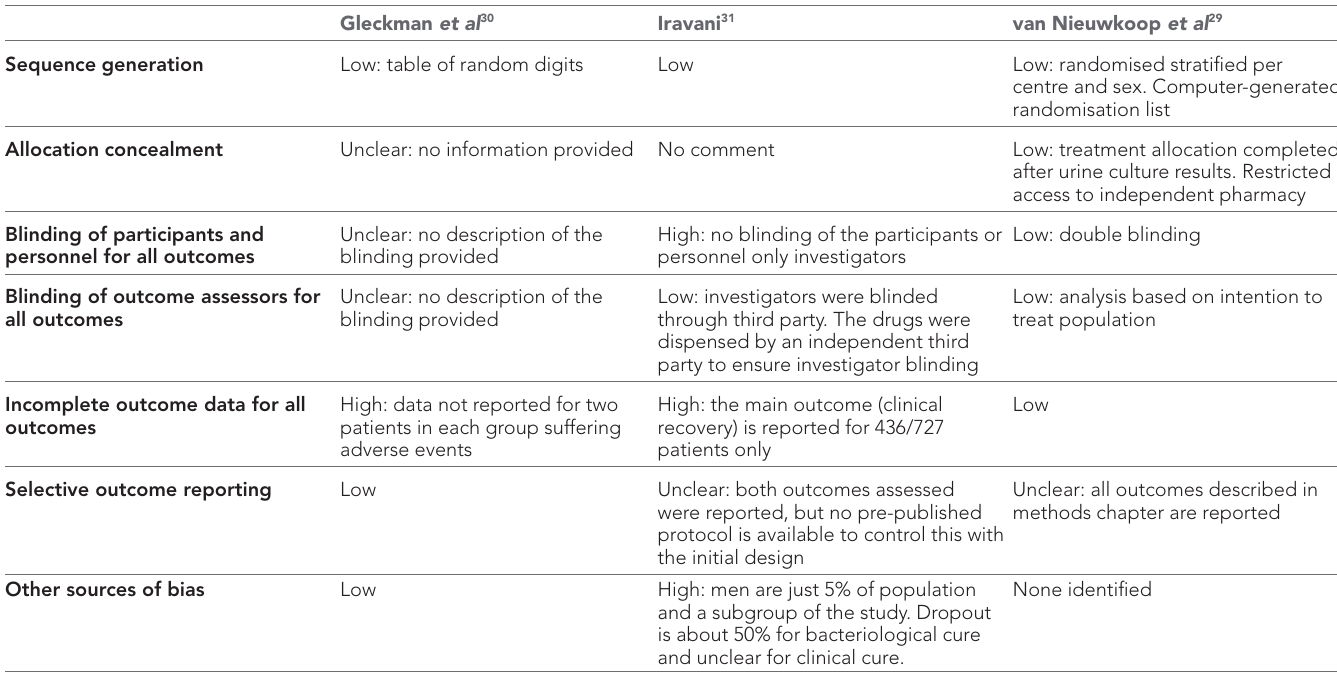
Table 3 Risk of bias